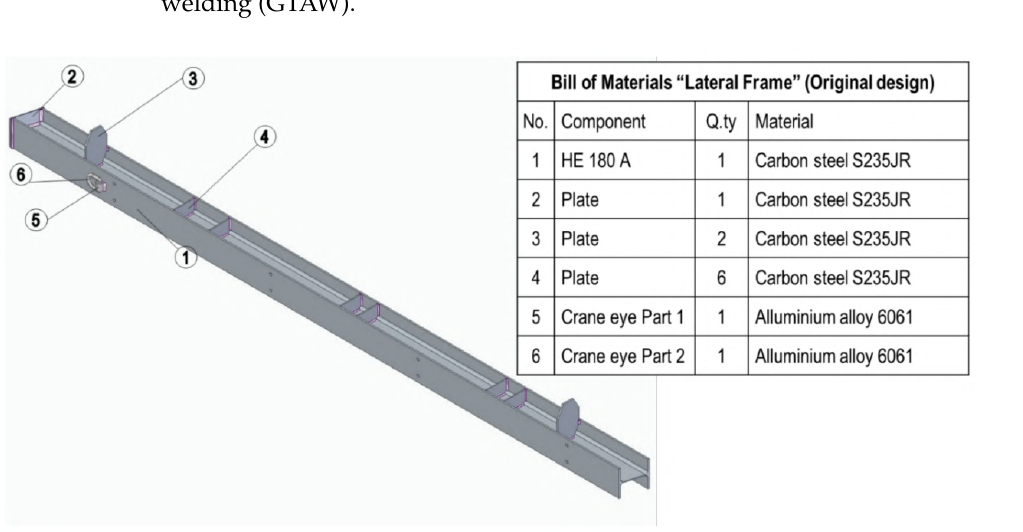
Figure 9. CAD model of the first sub-assembly (lateral frame).